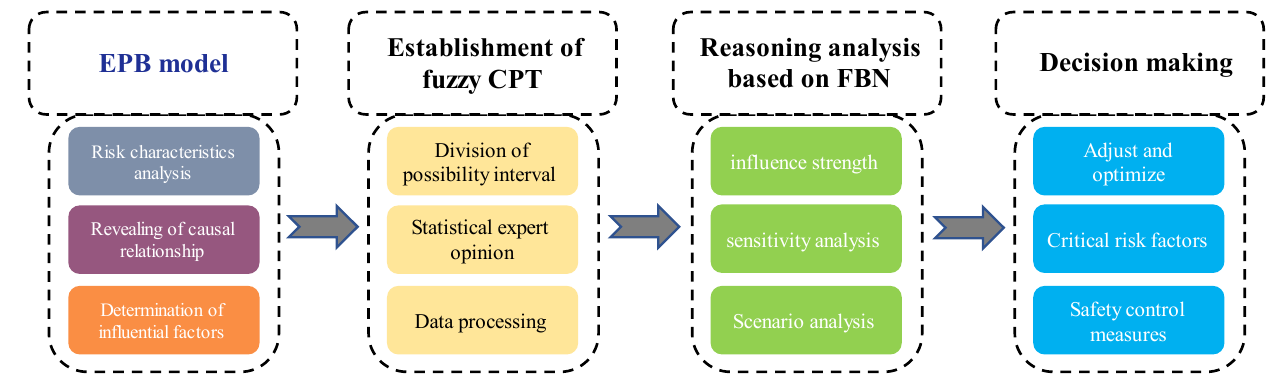
Figure 4. The evaluation process for UEF based on EPB-FBN.